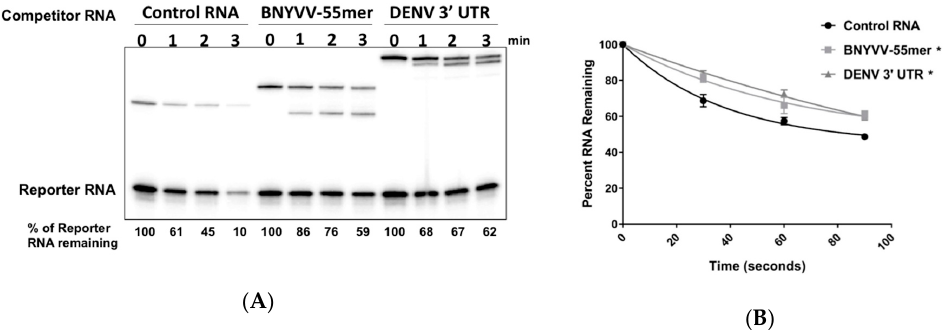
Figure 6. A 55 nt core fragment of RNA3 of BNYVV represses Xrn1. ( A ) A radiolabeled RNA containing a 5 ′ monophosphate (Reporter) was incubated with purified recombinant XRN1 for the times indicated. A 20X molar excess of lightly radiolabeled, 5 ′ monophosphorylated non-specific competitor RNA (‘Control RNA’ lanes), a competitor transcript containing the 55 nt core BNYVV RNA3 fragment (‘BNYVV-55mer’ lanes), or a competitor transcript containing the 3 ′ UTR of Dengue virus type 2 (‘DENV 3 ′ UTR’ lanes) was added to reactions. After the times indicated, reaction products were analyzed on 5% polyacrylamide gels containing urea and visualized by phosphorimaging. ( B ) Graphical presentation of the effect of the various competitor RNAs on Xrn1 activity on the Reporter transcript. Results shown are from three independent experiments. The asterisk represents a p value of <0.001 at both time points for viral 3 ′ UTR/BNYVV-55mer compared to the control as determined using a Turkey’s multiple comparisons test as a post-hoc test.